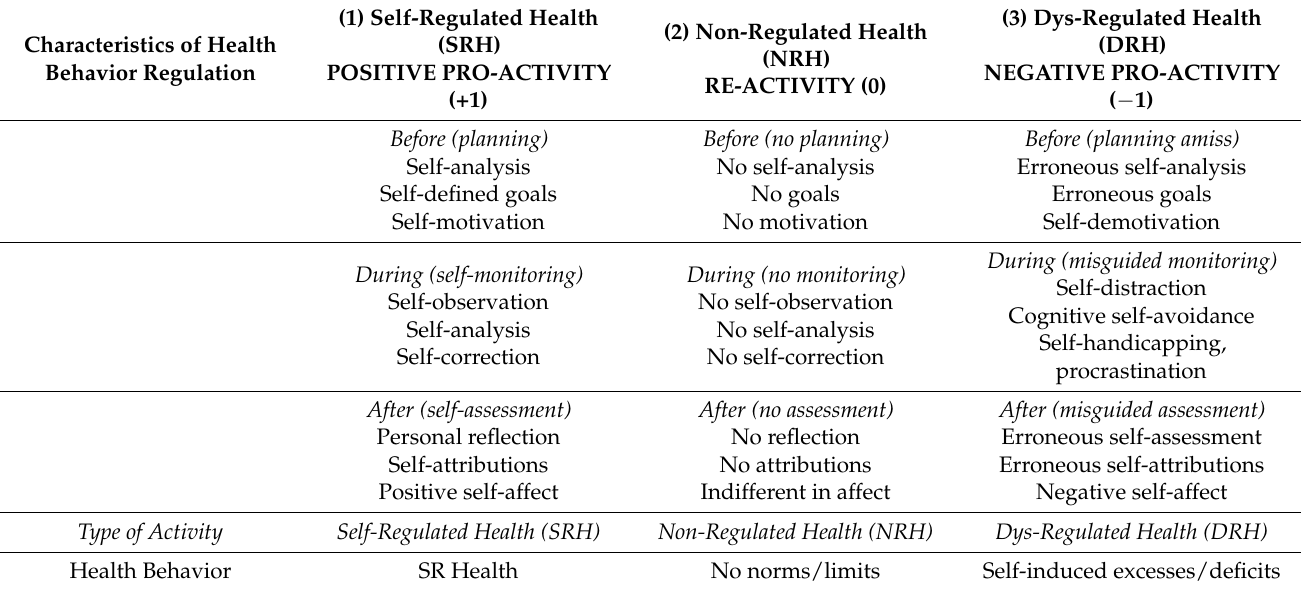
Table 1. Conceptual continuum and typologies of personal health